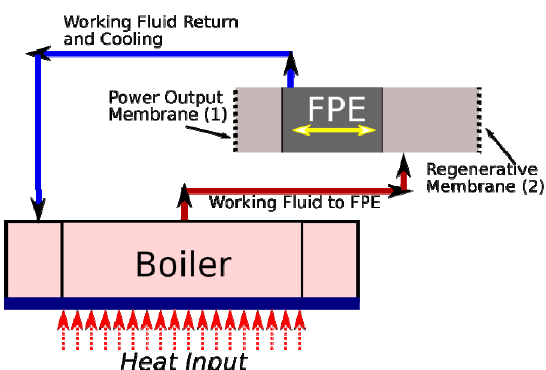
Figure 1. System overview (FPE—Free Piston Expander).